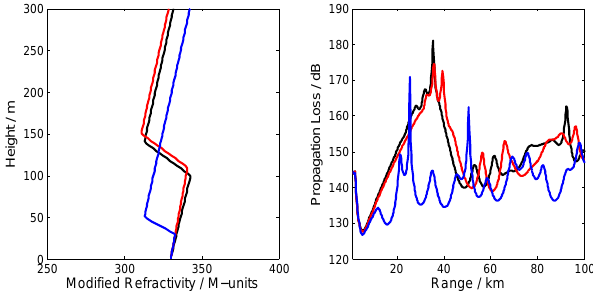
Fig. 2. Three different surface-based duct profiles and their corre- sponding propagation losses versus distance at the sea